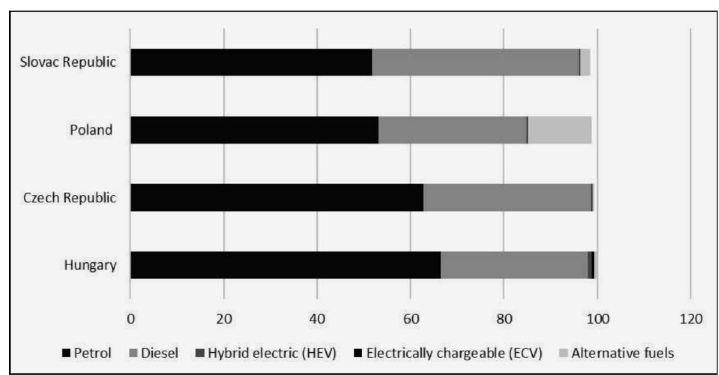
Passenger cars in use, by fuel type, % share, 2019